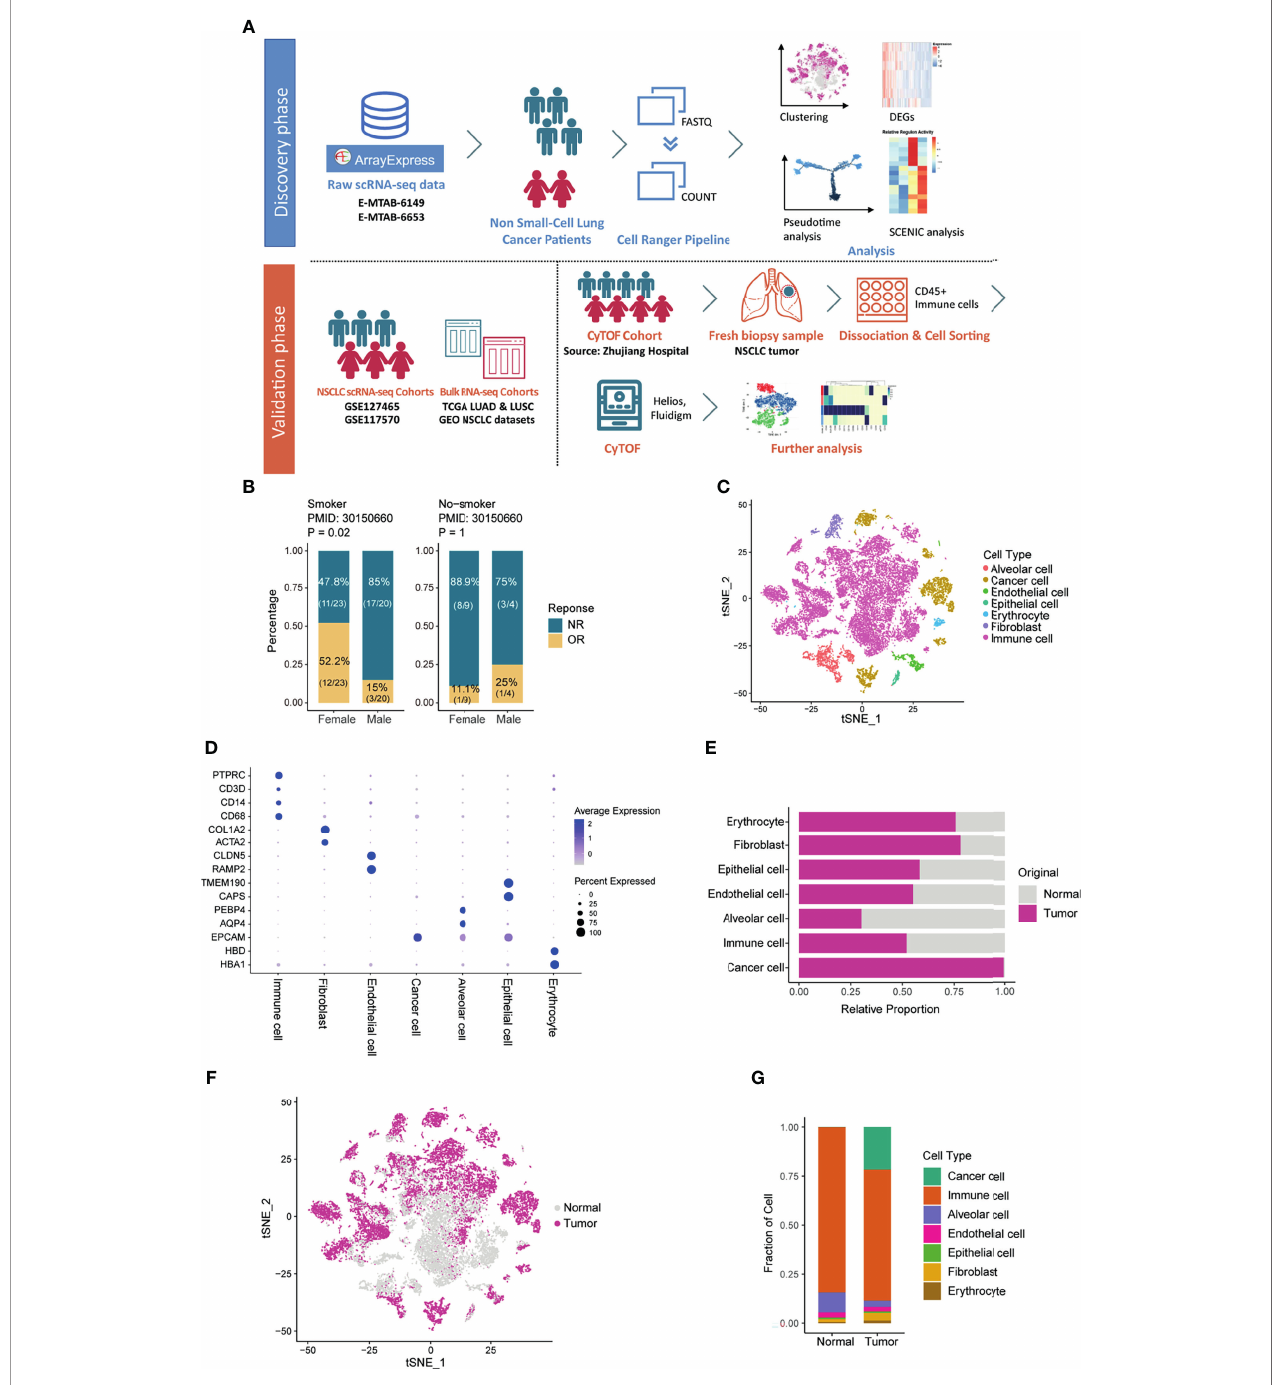
FIGURE 1 | Overview of the Cell Types in the Microenvironment of Non-small-cell Lung Cancer. (A) Work fl ow of the study design. (B) Bar plot showing the different response situations to immune checkpoint inhibitors of females and males, split by smoking status. Fisher ’ s exact test was used to compare the signi fi cance of the association between sexes and immune response. NR: no response; OR: objective response. (C) t-SNE plot showing the cell composition in the microenvironment of NSCLC, colored according to cell types. (D) Bubble heatmap showing expression of cell-type markers across cell clusters. Dot size indicates the percentage of expressed cells, colored by their relative expression levels. (E) Bar plot showing the fraction of each cell type according to the origin of samples. (F) t-SNE plot showing the cell distribution originated from tumor and normal lung samples. (G) Bar plot showing the overall cell composition of normal and tumor samples, colored by cell